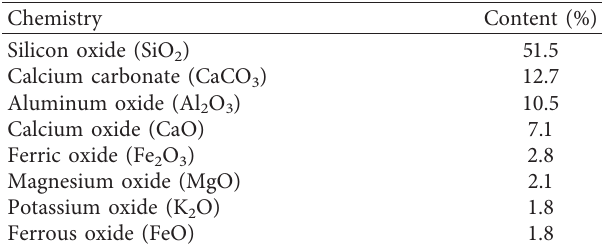
Table 2: Main chemical components of the